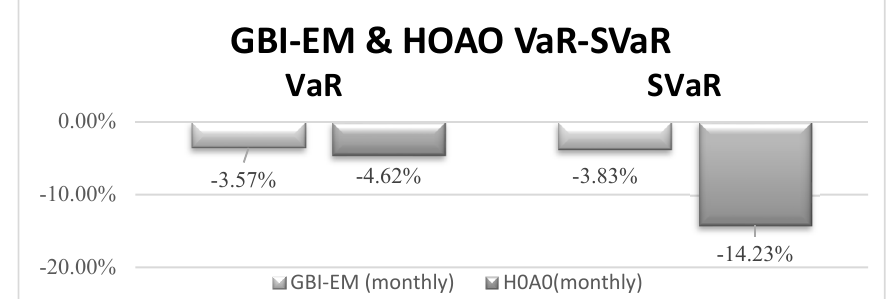
Figure 6. VaR versus SVaR bond index. Source: authors.